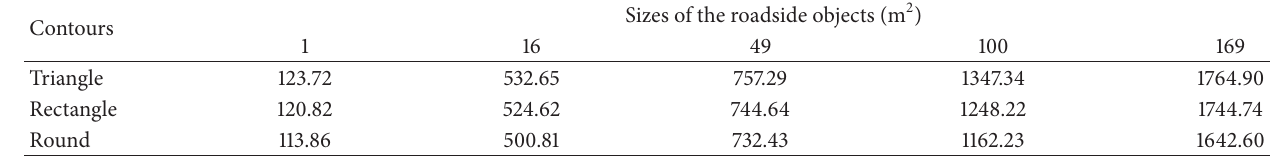
Table 4: The mean legibility distance under 100 km/h.